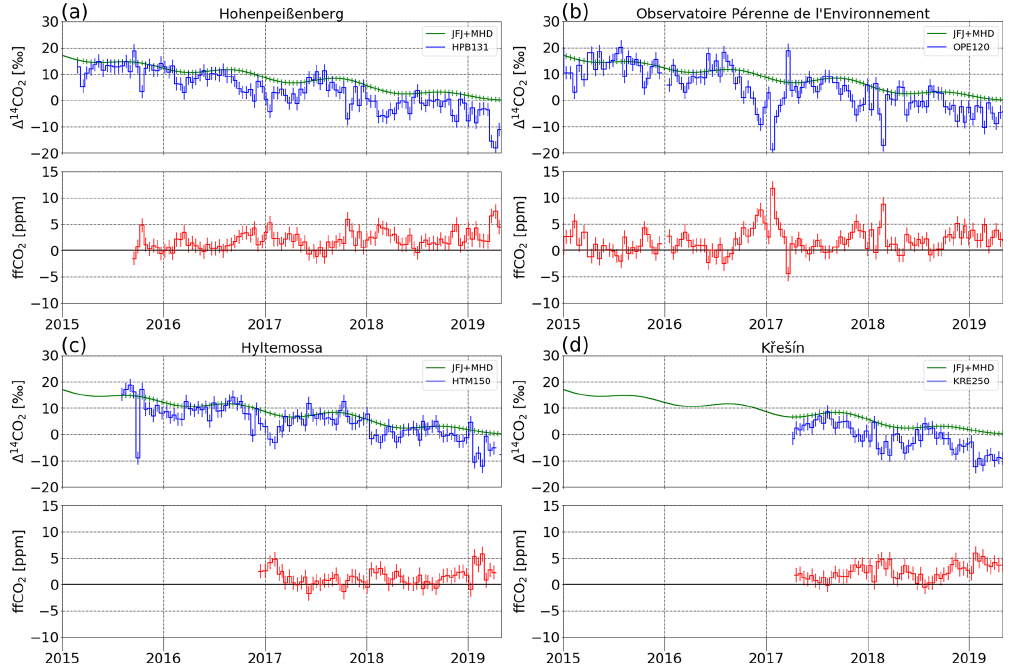
Figure 6. 14 CO 2 observations and estimated fossil fuel CO 2 concentrations relative to European background at the ICOS stations (a–d) Hohenpeißenberg, Observatoire Pérenne de l’Environnement, Hyltemossa, and Kˇrešín. The top panel for each station shows the (cid:49) 14 CO 2 results in permil deviation from the National Bureau of Standards (NBS) oxalic acid standard (Stuiver and Polach, 1977) for the respective station (blue histogram) together with the European background, which is estimated as the fit curve to measured data from Jungfraujoch (JFJ) and Mace Head (MHD). The bottom panel for each station gives the regional fossil fuel CO 2 offset calculated from the 14 CO 2 and CO 2 data, according to Levin et al. (2011). For Hohenpeißenberg and Hyltemossa, the ffCO 2 calculation starts later than the 14 CO 2 data since no ICOS CO 2 data are available in the early periods for these stations.